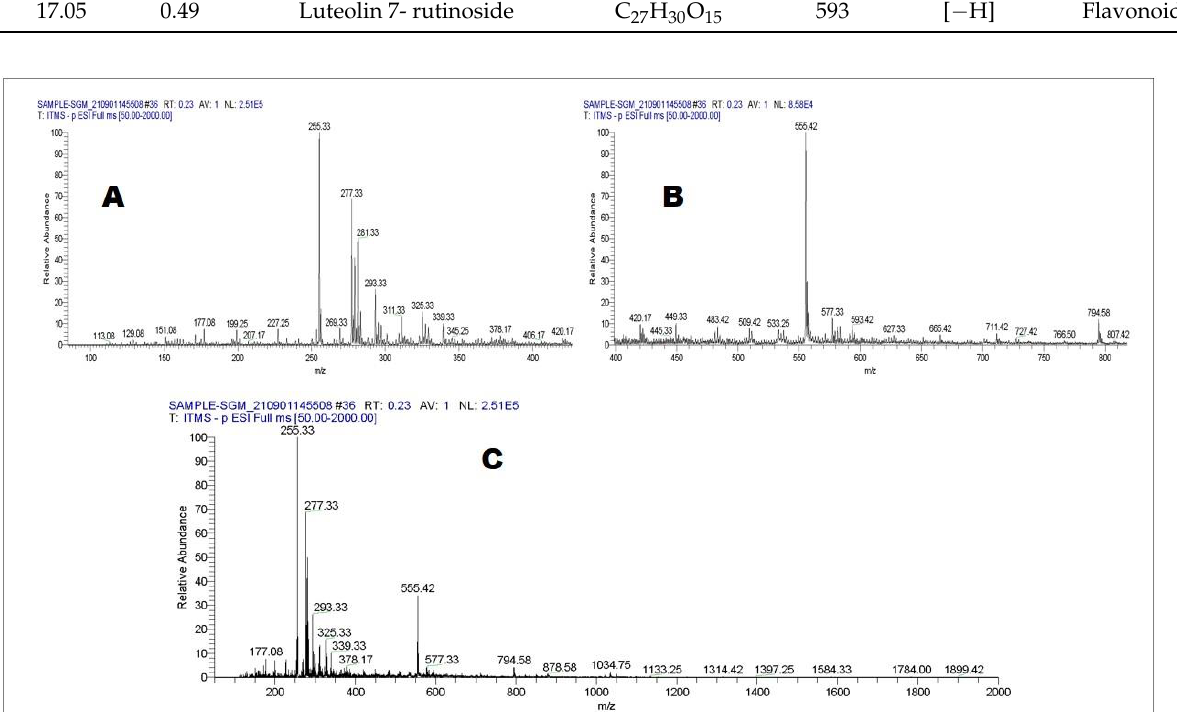
Figure 2. LC-ESI-MS-MS full scan of Strobilanthes glutinosus (negative mode) 50 – 400 ( A ), 50 – 800 ( B ), and 50 – 2000 ( C ).